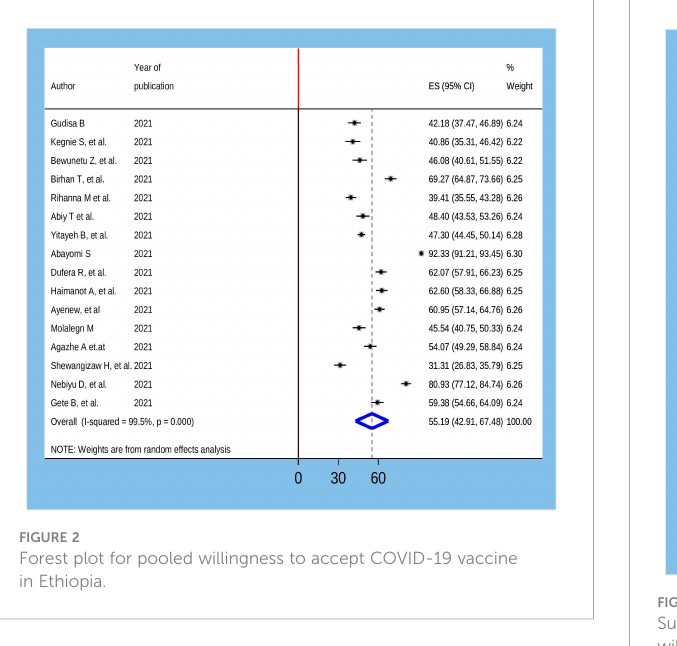
FIGURE 4 Sub group analysis based on the method of data collection for willingness to accept COVID-19 vaccine in Ethiopia, 2022.